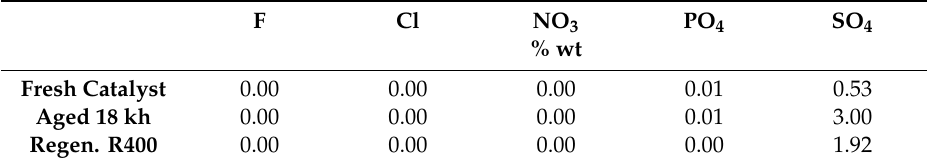
Table 4. Ion chromatography analysis showing the concentration of main anions in the supernatant water after washing samples of the fresh, reaction-aged, and thermally regenerated (R400) SCR catalyst. Results converted to weight% with respect to the catalyst sample. F Cl NO 3 PO 4 SO 4 % wt Fresh Catalyst 0.00 0.00 0.00 0.01